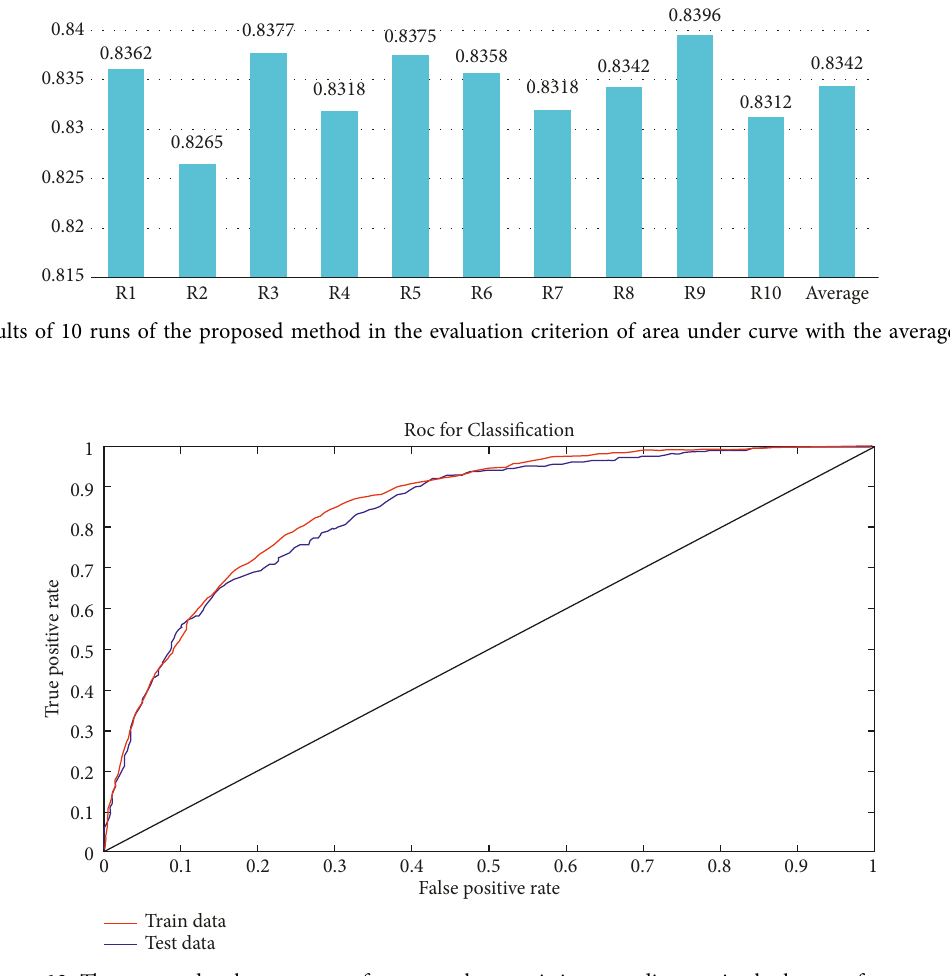
Figure 12: The area under the system performance characteristic curve diagram in the best performance.